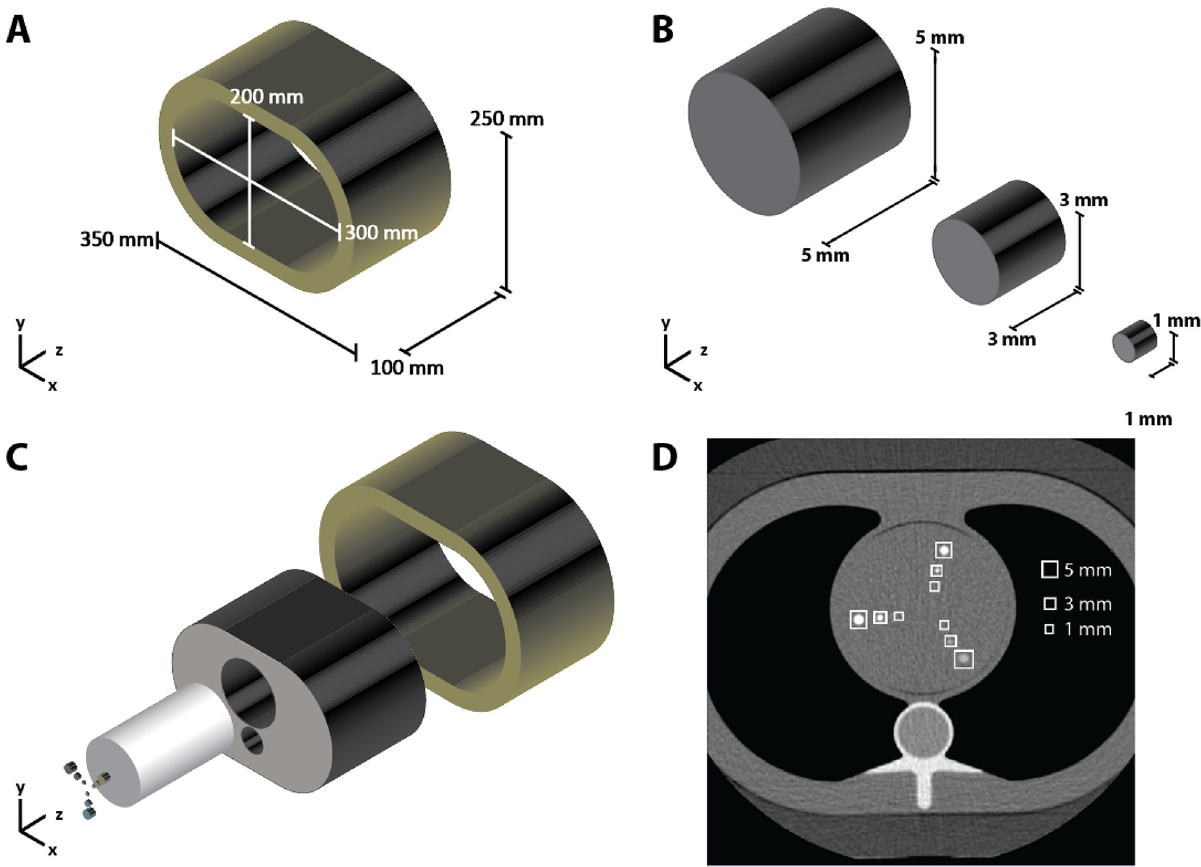
Fig 1. CEORA phantom: (A) Extension Ring M phantom used for girth simulation; (B) A set of three cylindrical calcifications; (C) The complete set- up of CEORA phantom with Cardio Calcification Insert containing nine cylindrical calcifications having different hydroxyapatite density values (800, 400 or 200 mg/cm 3 ) within the Anthropomorphic Thorax; (D) A slice of the CT-scanned CEORA phantom with calcification locations.